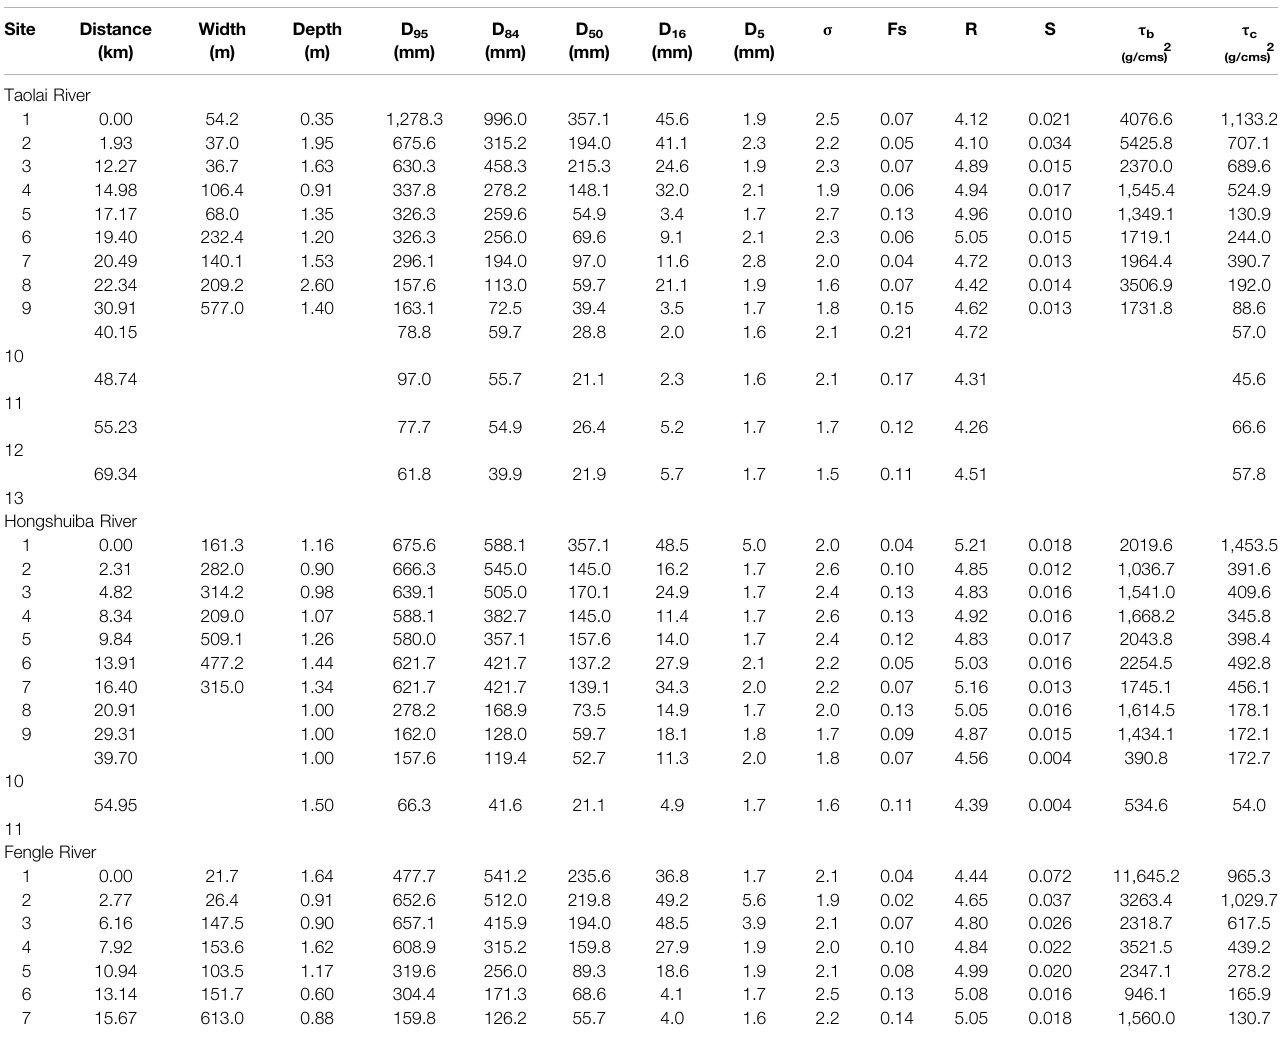
TABLE 1 | Results of analytical indices along the Taolai, Hongshuiba, and Fengle Rivers. Site Distance Width (km)